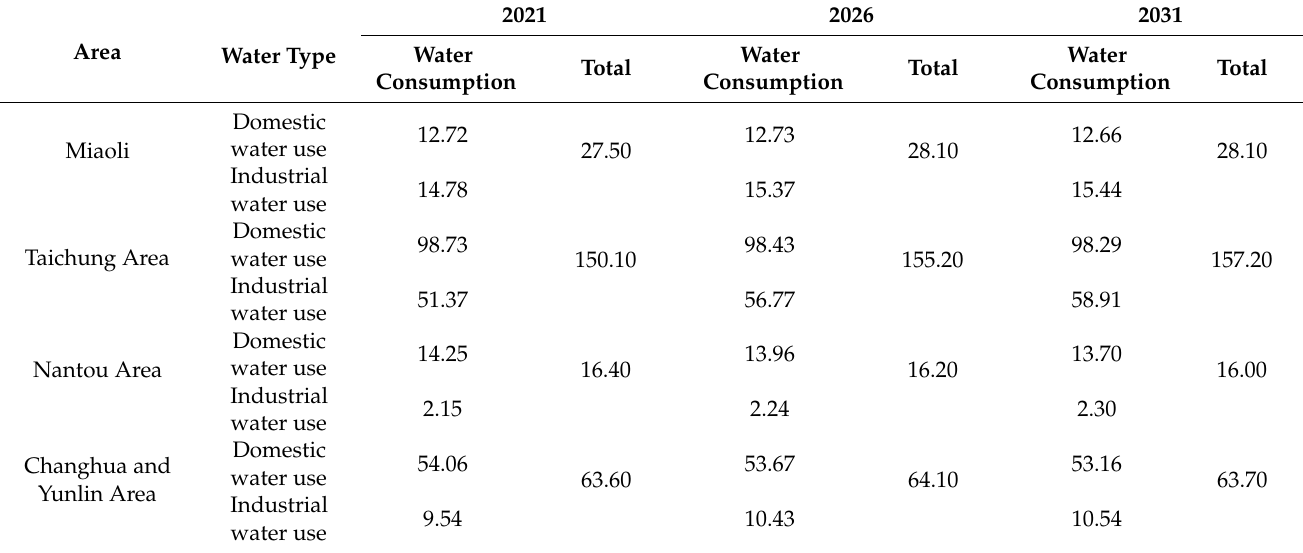
Table 1. Public Water Demand in Each Target Year by Area in Central Taiwan.